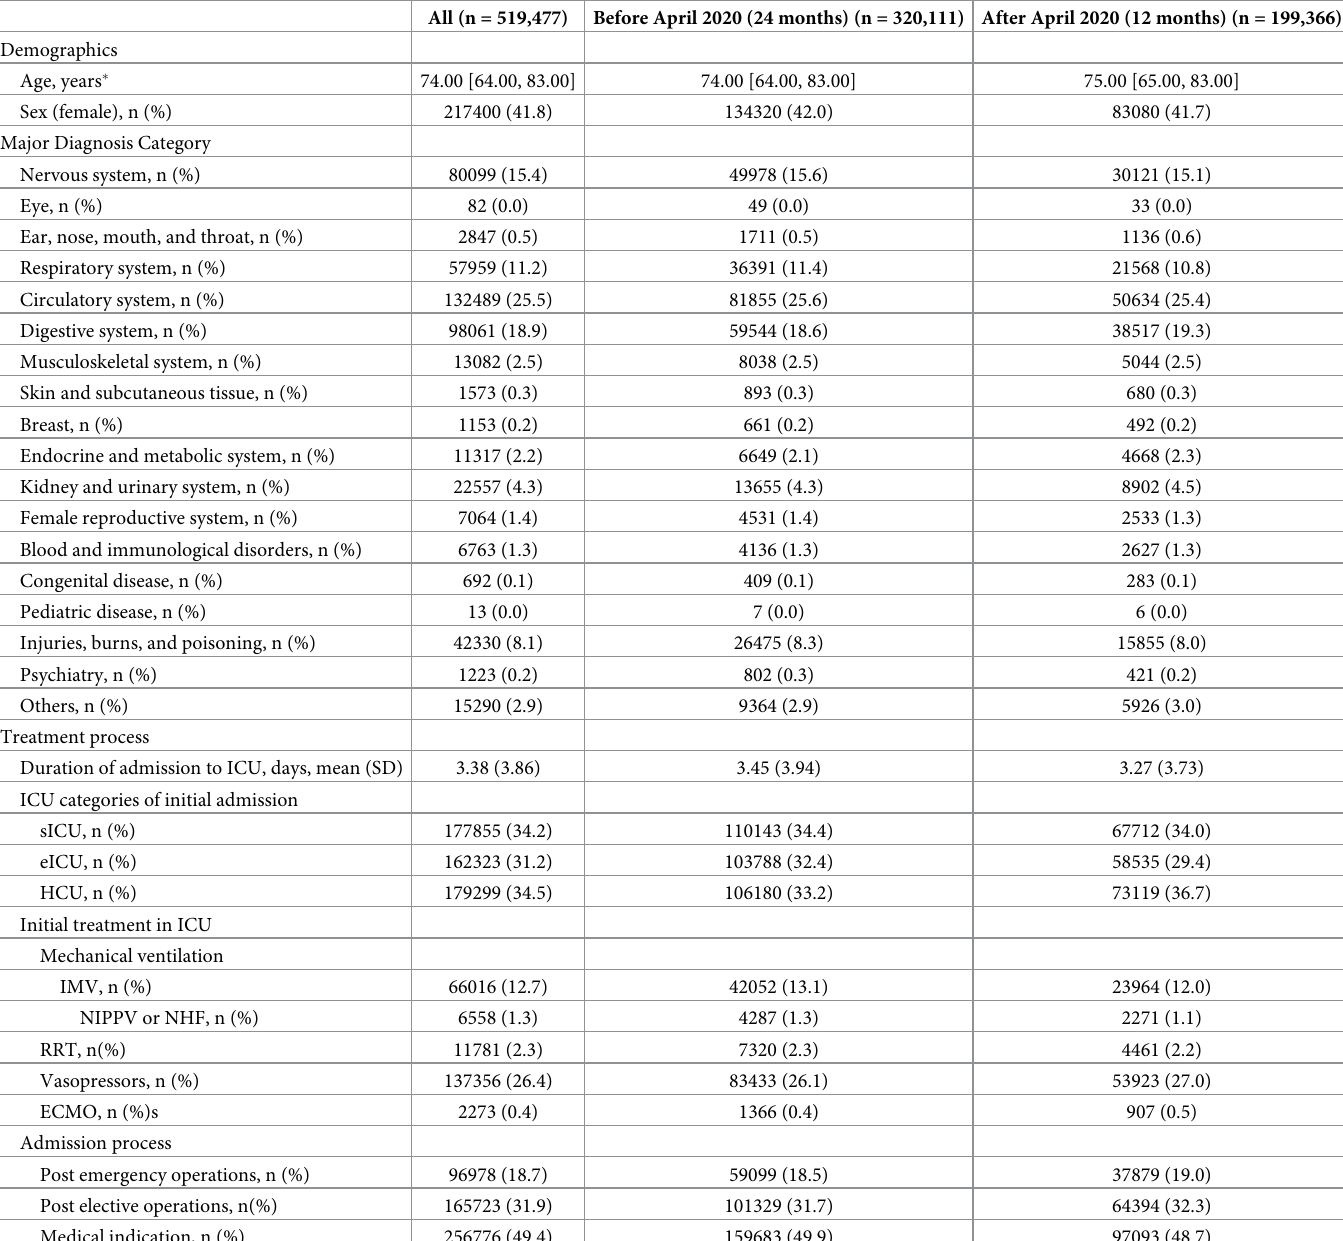
Table 1. Patient characteristics of the non-COVID-19 ICU